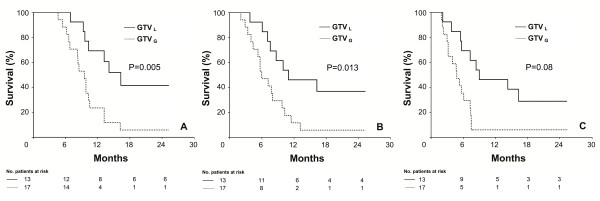
Comparative survival analyses between GTVL and GTVG cohorts. A: Overall Survival (OS); B: Local Regional Progression-free Survival (LRPFS), C: Progression-free Survival (PFS);. Solid line: GTVL; Dashed line: GTVG.